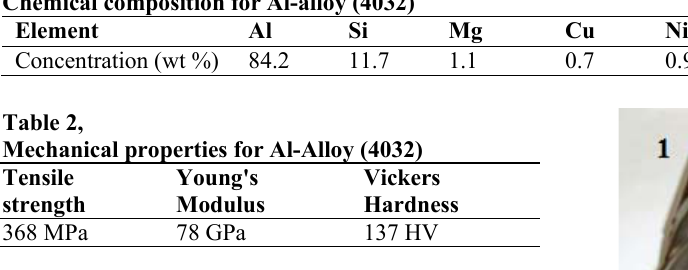
Young's Modulus